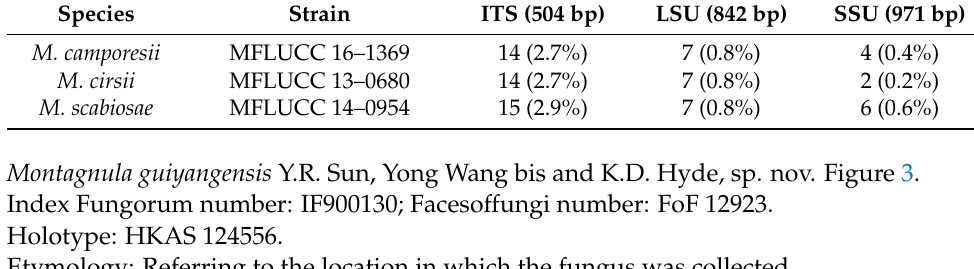
Table 1. The number of polymorphic nucleotide differences between M. aquatica (tef1- α not available) and M. camporesii , M. cirsii , and M. scabiosae (without gap). Species Strain ITS (504 bp) LSU (842 bp) Table 2. The number of polymorphic nucleotide differences between M. guiyangensis HKAS 124556 and M. aloes , M. appendiculata , M. chiangraiensis , and M. chromolaenae (without gap).